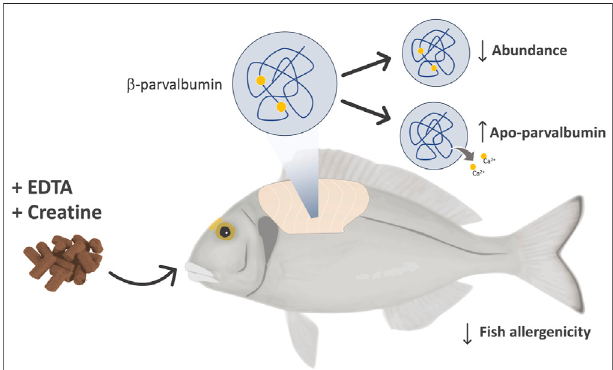
FIGURE 1 | From diagnosis to traditional and advanced clinical approaches to manage fi sh-allergic patients. Under strict avoidance of any type of fi sh, patients risk maintaining their food allergy over lifetime. The consumption of single, individually tolerated fi sh species contributes to a balanced diet and most likely, promotes tolerance development. Hypoallergenic fi sh species, either naturally occurring or produced in targeted aquaculture,arekeycomponentstoimplementsuchapersonalizedapproach in patient care.